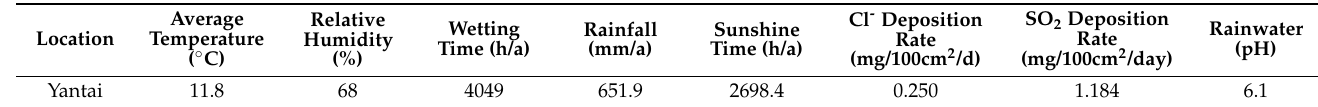
Table 2. Environmental data of Q235 carbon steel exposure.